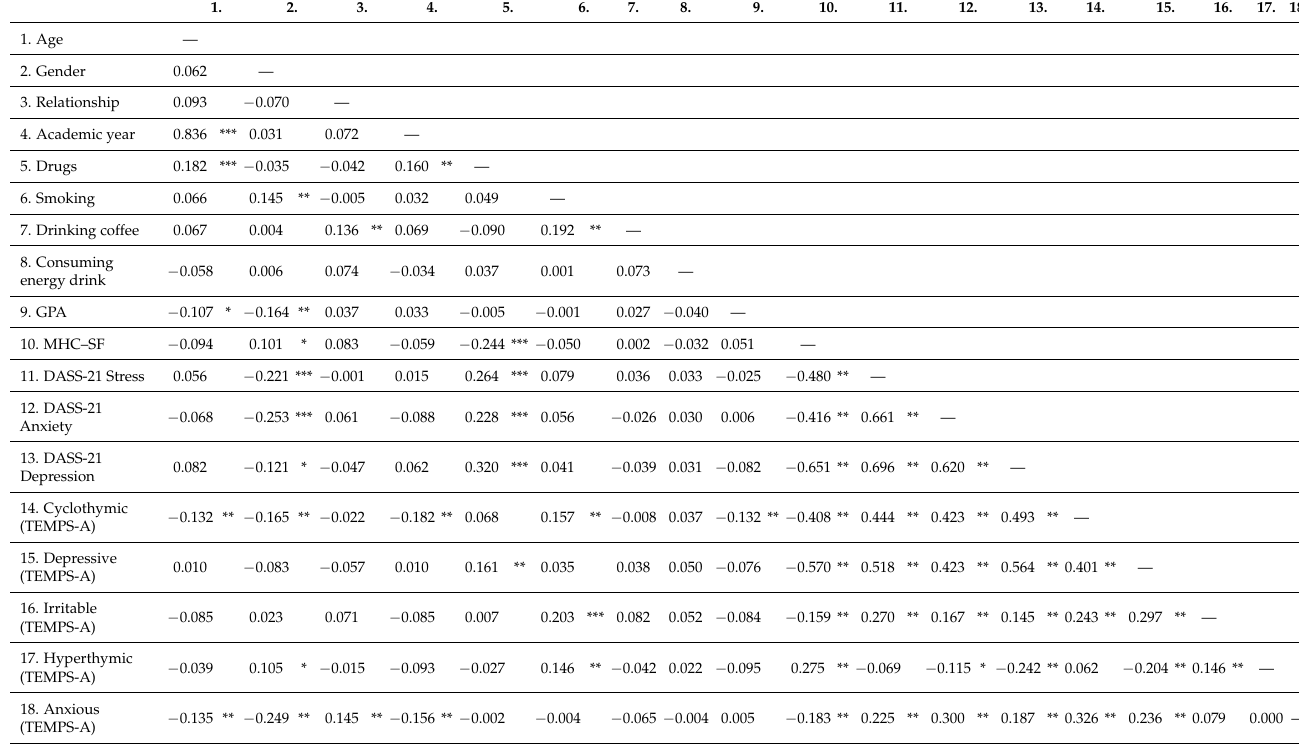
Table 4. Correlations between study